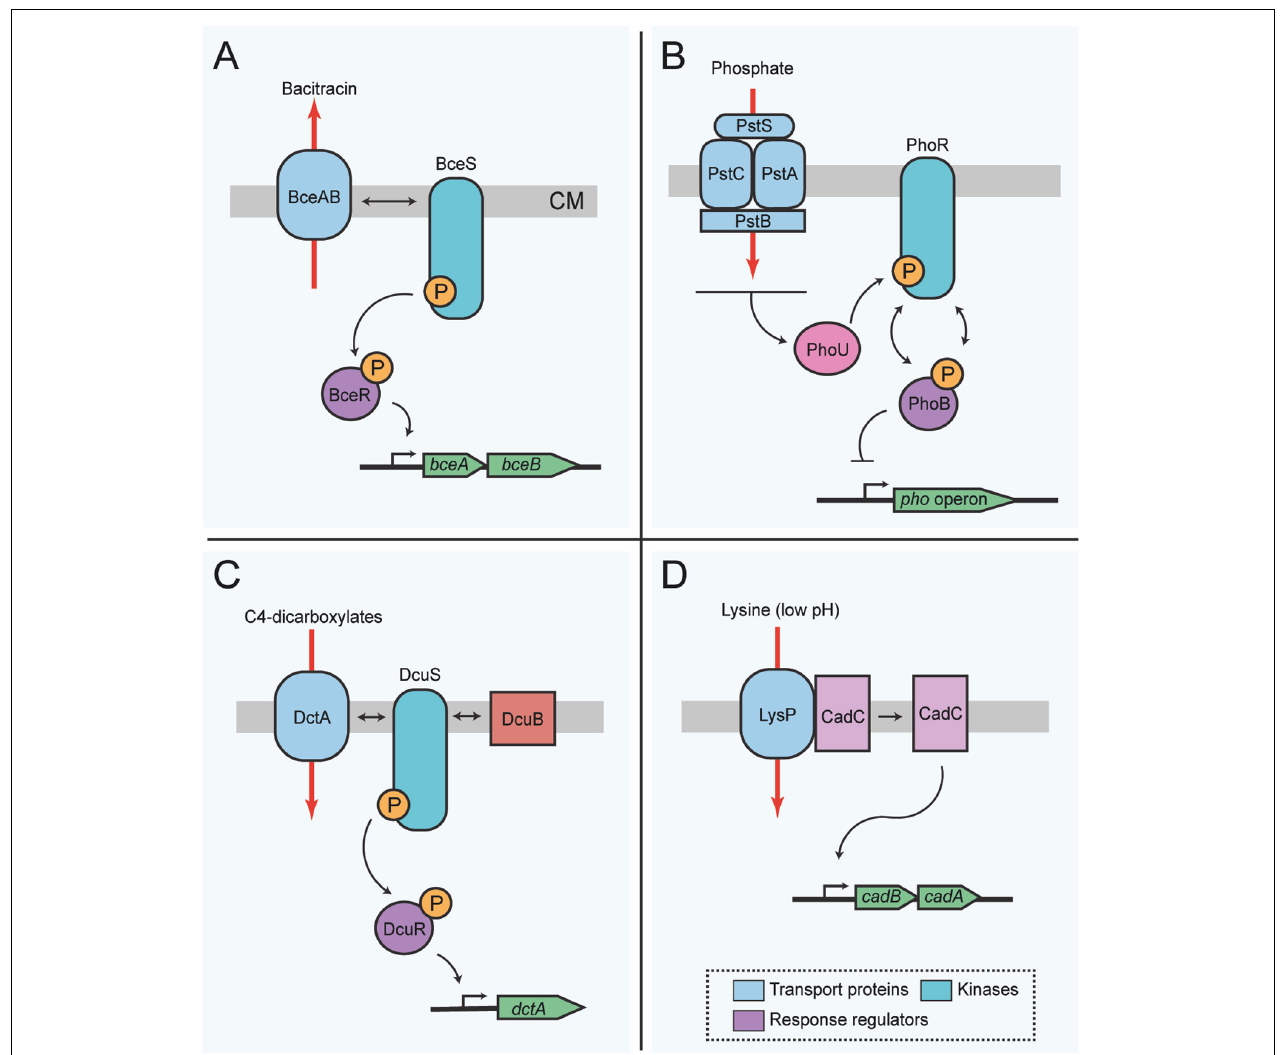
FIGURE 2 | Membrane transport functions involved in bacterial protein activity or flux sensing for metabolic homeostasis. (A) Flux-sensing by the BceRS-BceAB system described in B. subtilis for detoxification of bacitracin. The transporter proteins BceAB sense bacitracin, and such activity influences activation of the kinase BceS, which in turn activates the response regulator protein BceR. Active BceR recruits RNA polymerase for the transcription of genes required for the synthesis of more transporter proteins needed for detoxification of the cell. Thus, changes in the activity of the transporters is signaled from BceS to BceR, and the amount of BceR-P is proportional to the bacitracin load on the transporters. In this way, the transporter proteins are both, the sensor and the means for antibiotic resistance. (B) Sensing of external phosphate in E. coli via PhoR-PhoB. The phosphate transporter complex PstCAB perceives external phosphate levels. Phosphate binds to the transporter complex, which then transfers this information to the histidine kinase PhoR via the chaperone protein PhoU. In its default state, PhoR autophosphorylates and subsequently transfers the phosphoryl group to the response regulator protein, PhoB. However, upon phosphate binding to PstS, phosphorylation of PhoR and thus PhoB is inhibited, resulting in a concomitant decrease of the transcription of the pho regulon. (C) Sensor switch of DcuS-DcuR or DctS-DctR in E. coli and B. subtilis , respectively. Sensing of C4-dicarboxylate compounds occurs indirectly through the kinase DcuS, which complexes with transport proteins, in this example DctA and the accessory protein DcuB. Complexing of the transport protein and DcuS activates kinase activity, initiating the phoshorelay to the response regulator protein, DcuR, and ultimately inducing expression of genes for the synthesis of more transporter proteins that will eventually complex with the kinase for an increased uptake of C4-dicarboxylates. Several genes important for the synthesis of proteins required to degrade external C4-dicarboxylates are under the control of this switch; however, for simplicity only dcuB is shown. (D) Regulatory interplay between LysP and CadC. In the presence of lysine (K) at low pH ( ≤ 5.8) the lysine permease LysP interaction with the sensor protein CadC is prevented, allowing the release of CadC, which in turn induces the expression of cadAB . Red arrows indicate the direction of transport. Box includes the color conventions of shared elements between systems. CM,